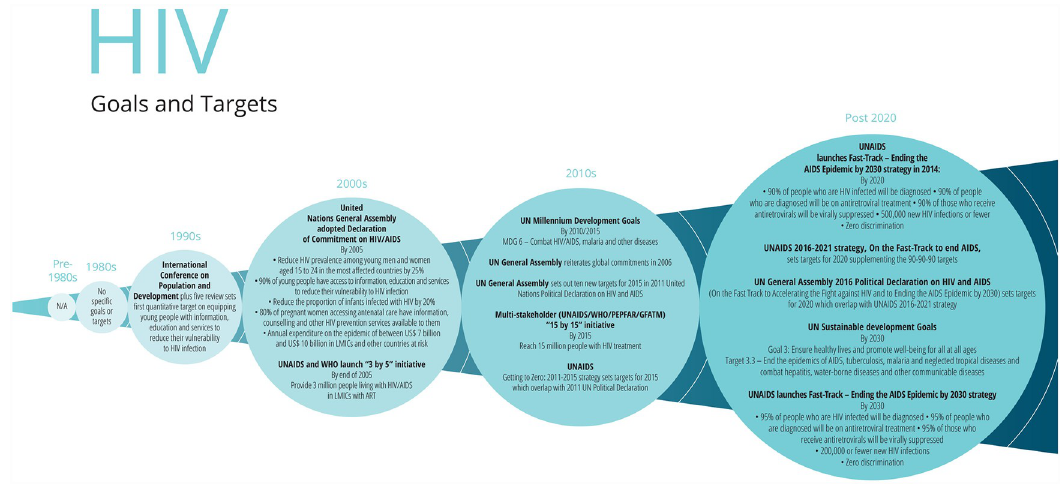
Fig 4. Major goals and targets for HIV/AIDS. ART, antiretroviral therapy; GFATM, Global Fund to Fight AIDS, Tuberculosis and Malaria; LMIC, low- or middle-income country; MDG, Millennium Development Goal; PEPFAR, US President’s Emergency Plan for AIDS Relief; UNAIDS, Joint United Nations Programme on